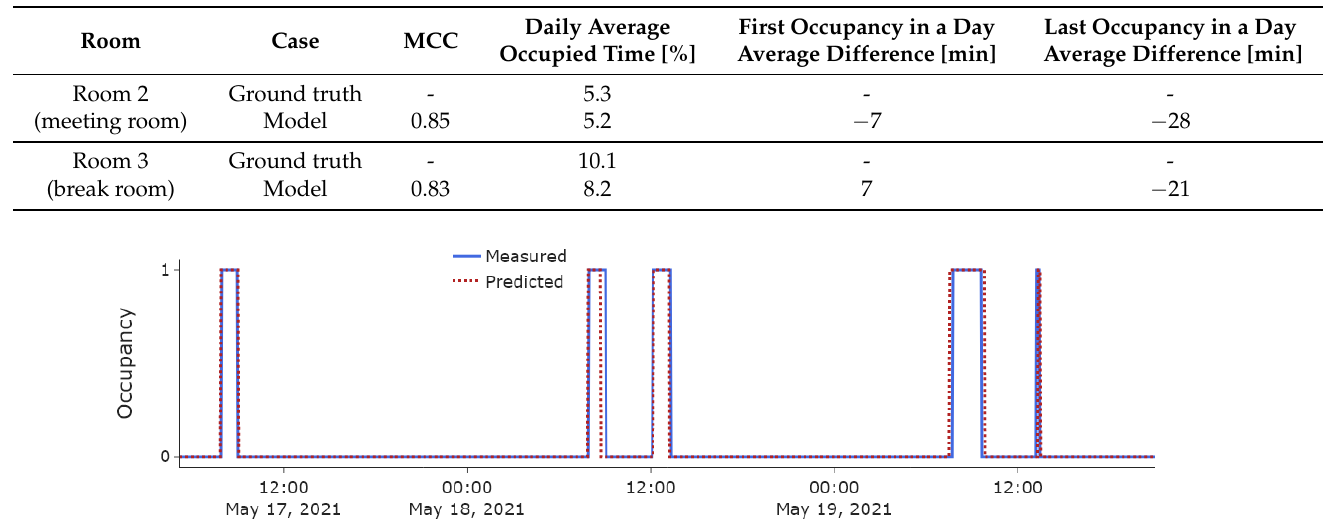
Figure 7. Three-day showcase of the target occupancy detection model performance on room 2 (meeting